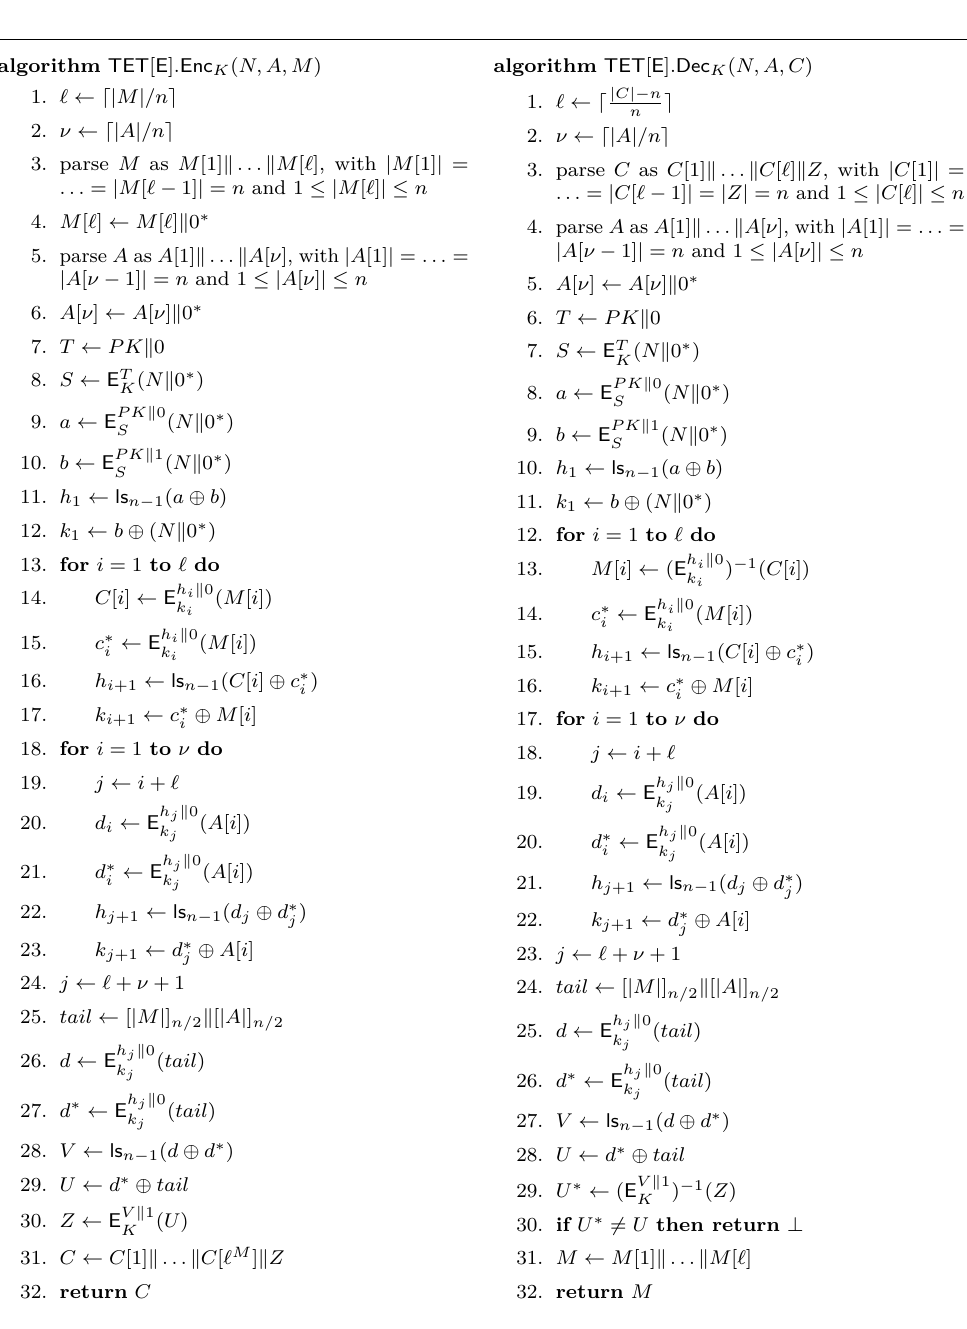
Figure 14: Definition of the TET mode, using a TBC E